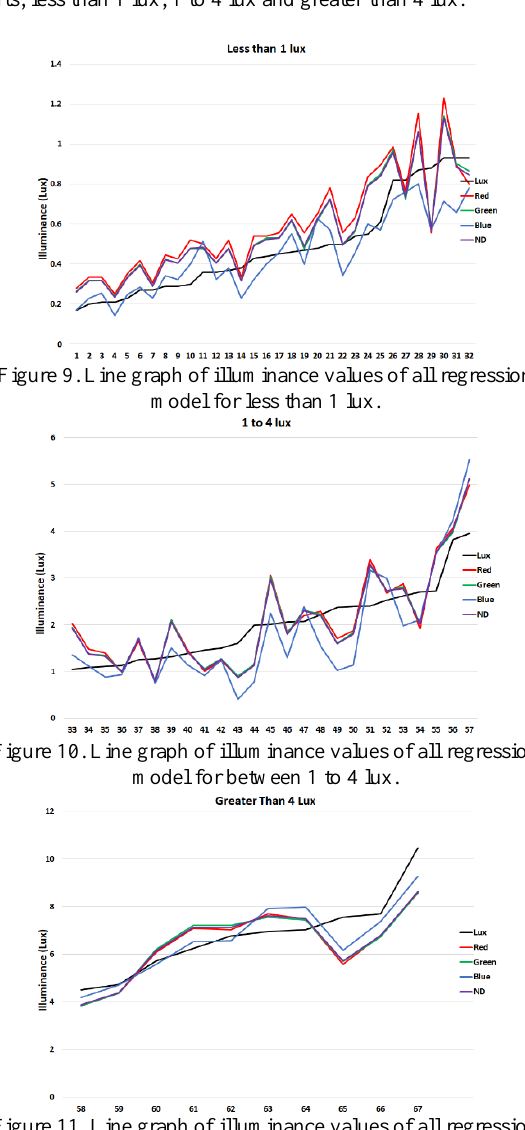
Figure 11. Line graph of illuminance values of all regression model for greater than 4 lux.